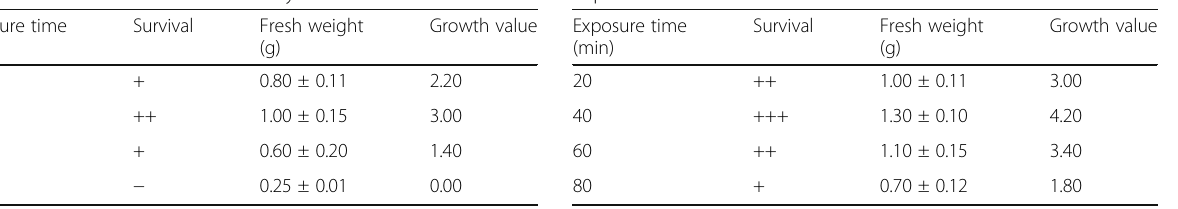
Table 4 Regrowth of cryopreserved callus of globe artichoke exposed for different time to